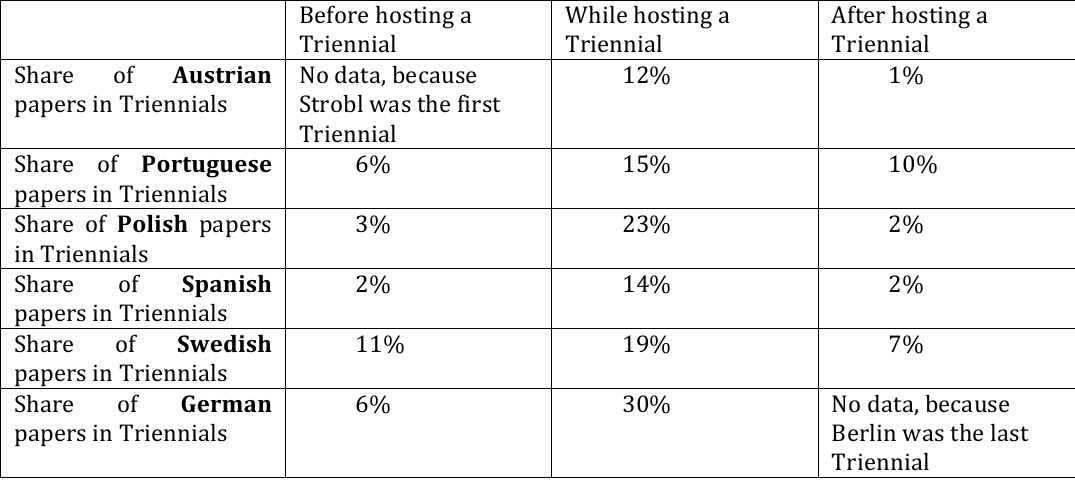
Table 3: ESREA conferences and the share of papers from host countries before, during and after hosting a